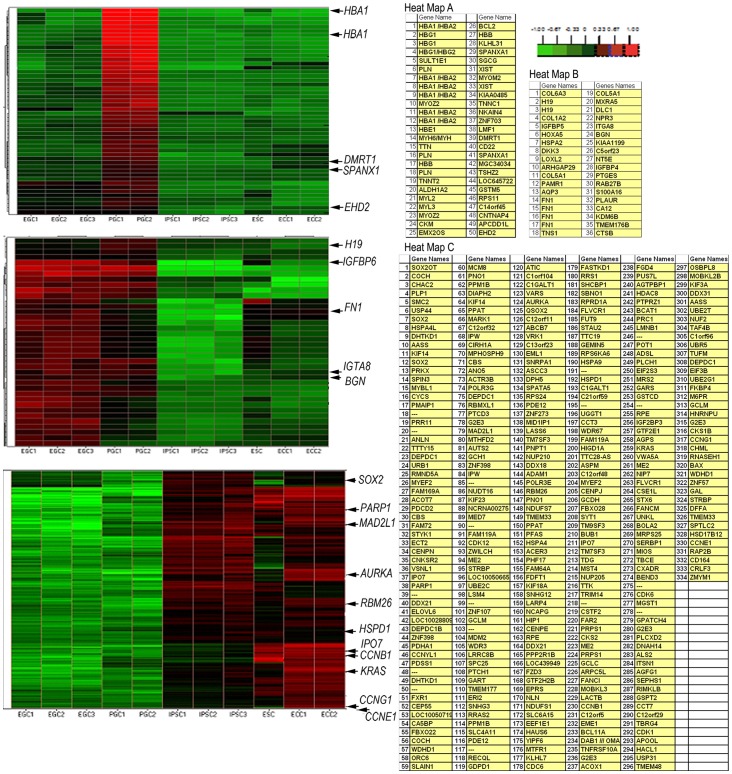
Hierarchical clustering of potential signature genes.Gene expression levels of (A) PGC signature, (B) EGC and common PGC/EGC signature and (C) ESC, IPSC and ECC group genes are represented in a heat map. Lists of genes corresponding to each group are on the right hand side of the cluster tree. Order of the genes in the tables corresponds to their order in the heat map (high expression in red, log10 = >1.00; low expression in green; log10 = <–1.00).